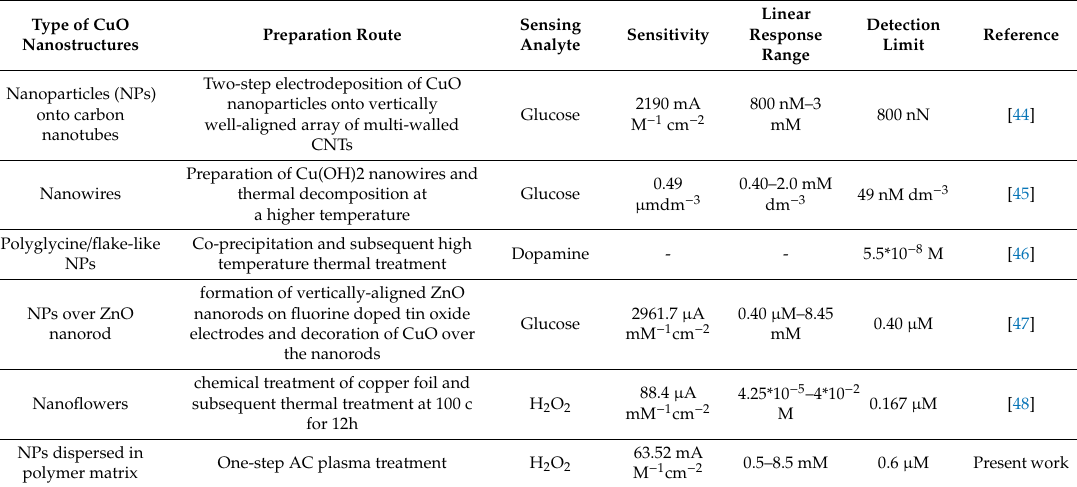
Table 2. Electrocatalytic sensor based on the CuO nanostructure prepared by various preparation methods. Type of CuO